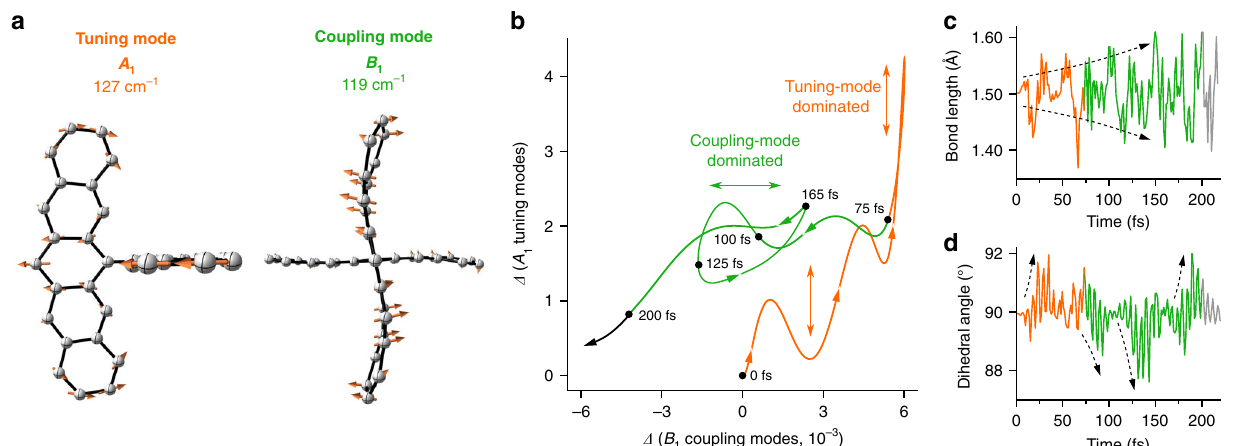
Fig. 5 Coupling and tuning-mode behaviour in DP-Mes. a Representative normal-mode examples of a tuning (left) and a coupling mode (right). The molecular structure was truncated to the core pentacene units for clarity. b Correlation plot of the total time-dependent displacement amplitude of A 1 tuning and B 1 coupling modes. Contour arrows indicate the direction of evolution and black dots indicate the time of the trajectory. The initial motion is dominated by tuning modes (orange vertical arrows) before a rapid damping of the tuning modes funnels the energy into the coupling modes (green horizontal arrow). c Central pentacene – pentacene bond length and d dihedral angle during the ultrafast singlet fi ssion reaction. Traces are colour coded to match panel ( b ) and dashed arrows indicate signi fi cant increases in the values of the